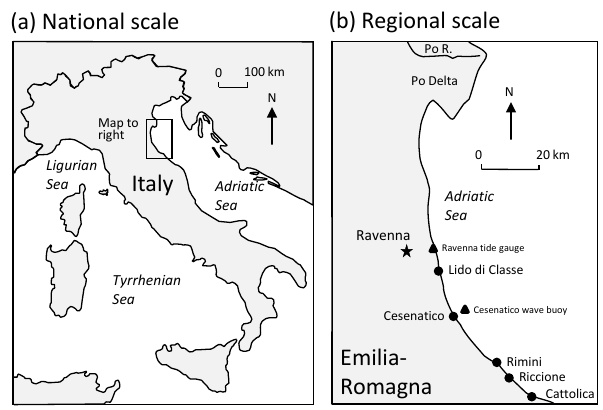
Figure 1. Map of the Emilia-Romagna region in northern